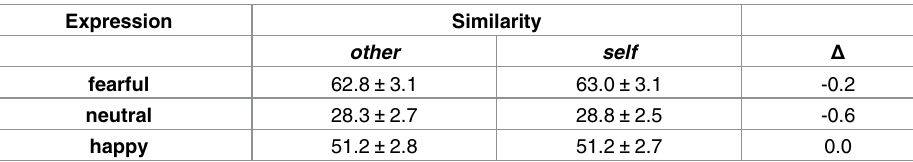
Table 1. Mean ratings of arousal (Exp. I).